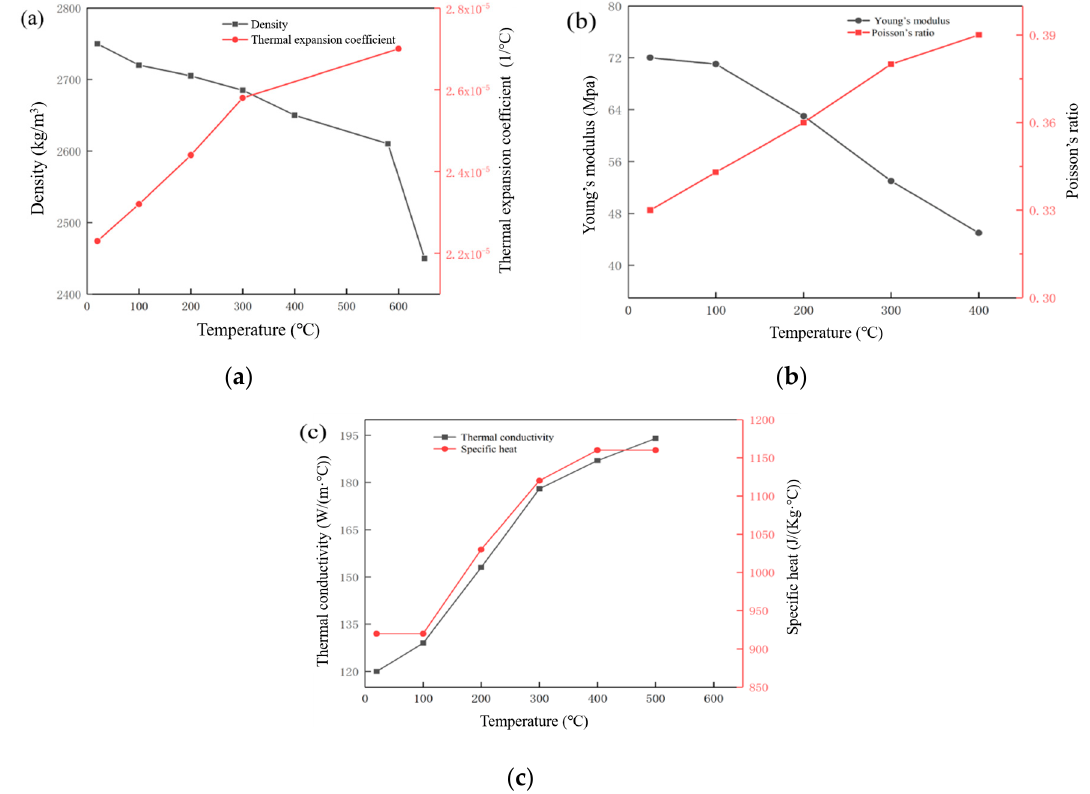
Figure 2. Thermophysical properties of aluminum alloy 2024 with temperature change. ( a ) Density and thermal expansion coefficient; ( b ) Young’s modulus and Poisson’s ratio; ( c ) thermal conduction coefficient and specific heat capacity [35].